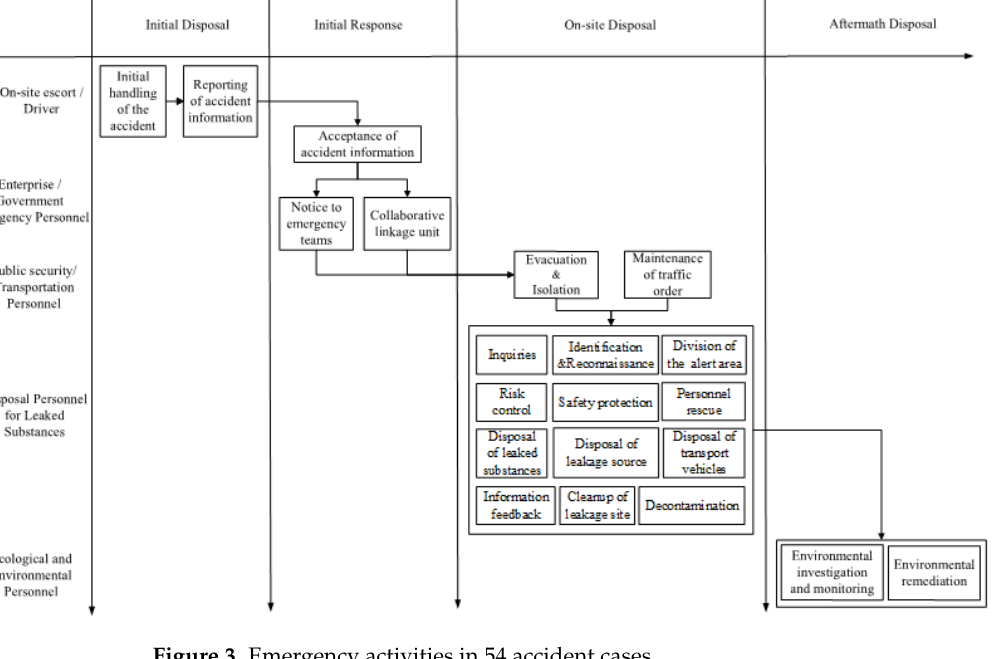
Figure 4. Emergency activities map of road transportation leakage accidents of hazardous chemicals. According to Figure 4, 24 emergency activities for road transportation leakage acci- dents of hazardous chemicals were obtained, as shown in Table 3.